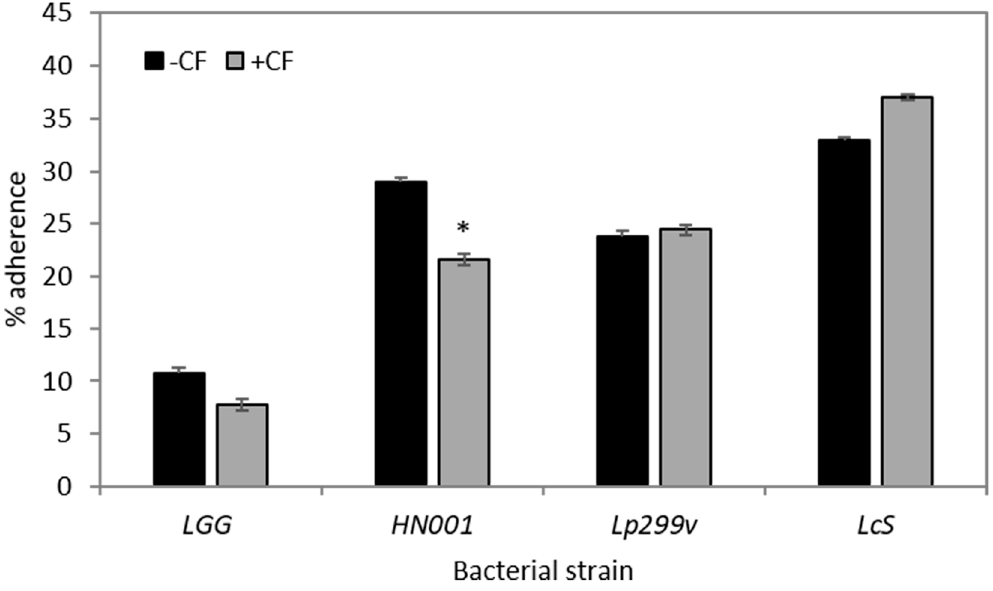
Figure 3. Influence of a carbohydrate fraction (CF) from caprine milk (CF; 4 mg/mL) on the adherence of bacteria (as percentage of inoculum) to 90:10 Caco-2:HT29–MTX co-cultures. Data are expressed as the means (±SEM) for three experiments (three samples per treatment per experiment); n = 3. * = Significantly different ( P < 0.05) to respective bacteria only treated monolayers. LGG = L. rhamnosus GG; HN001 = L. rhamnosus HN001; Lp299v = L. plantarum 299v and LcS = L. casei Shirota.